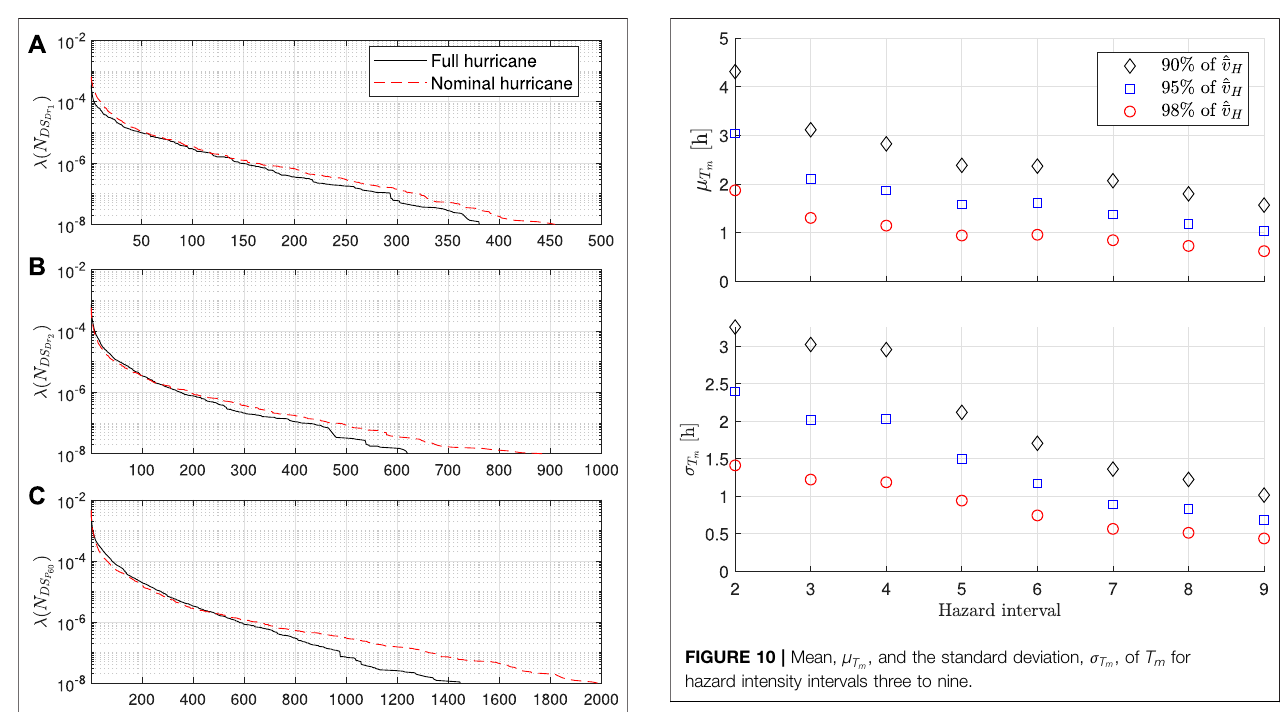
, and the standard deviation, σ T m